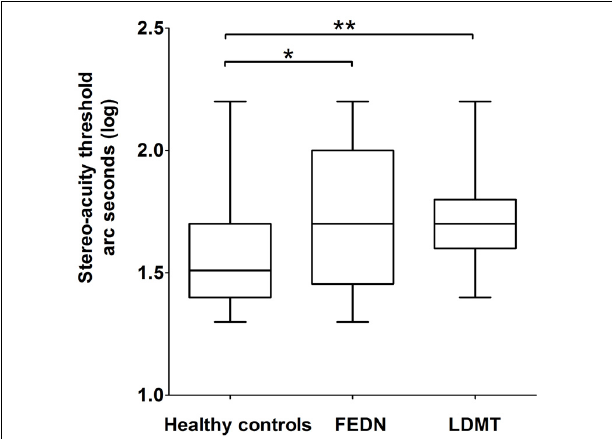
FIGURE 1 | Difference in binocular depth perception stereo acuity (log seconds of arc) between healthy controls, first-episode and drug-naive patients of schizophrenia (FEDN) and long duration of illness and medicine treatment (LDMT). ∗ Indicates P < 0.05; ∗∗ indicates P < 0.01.